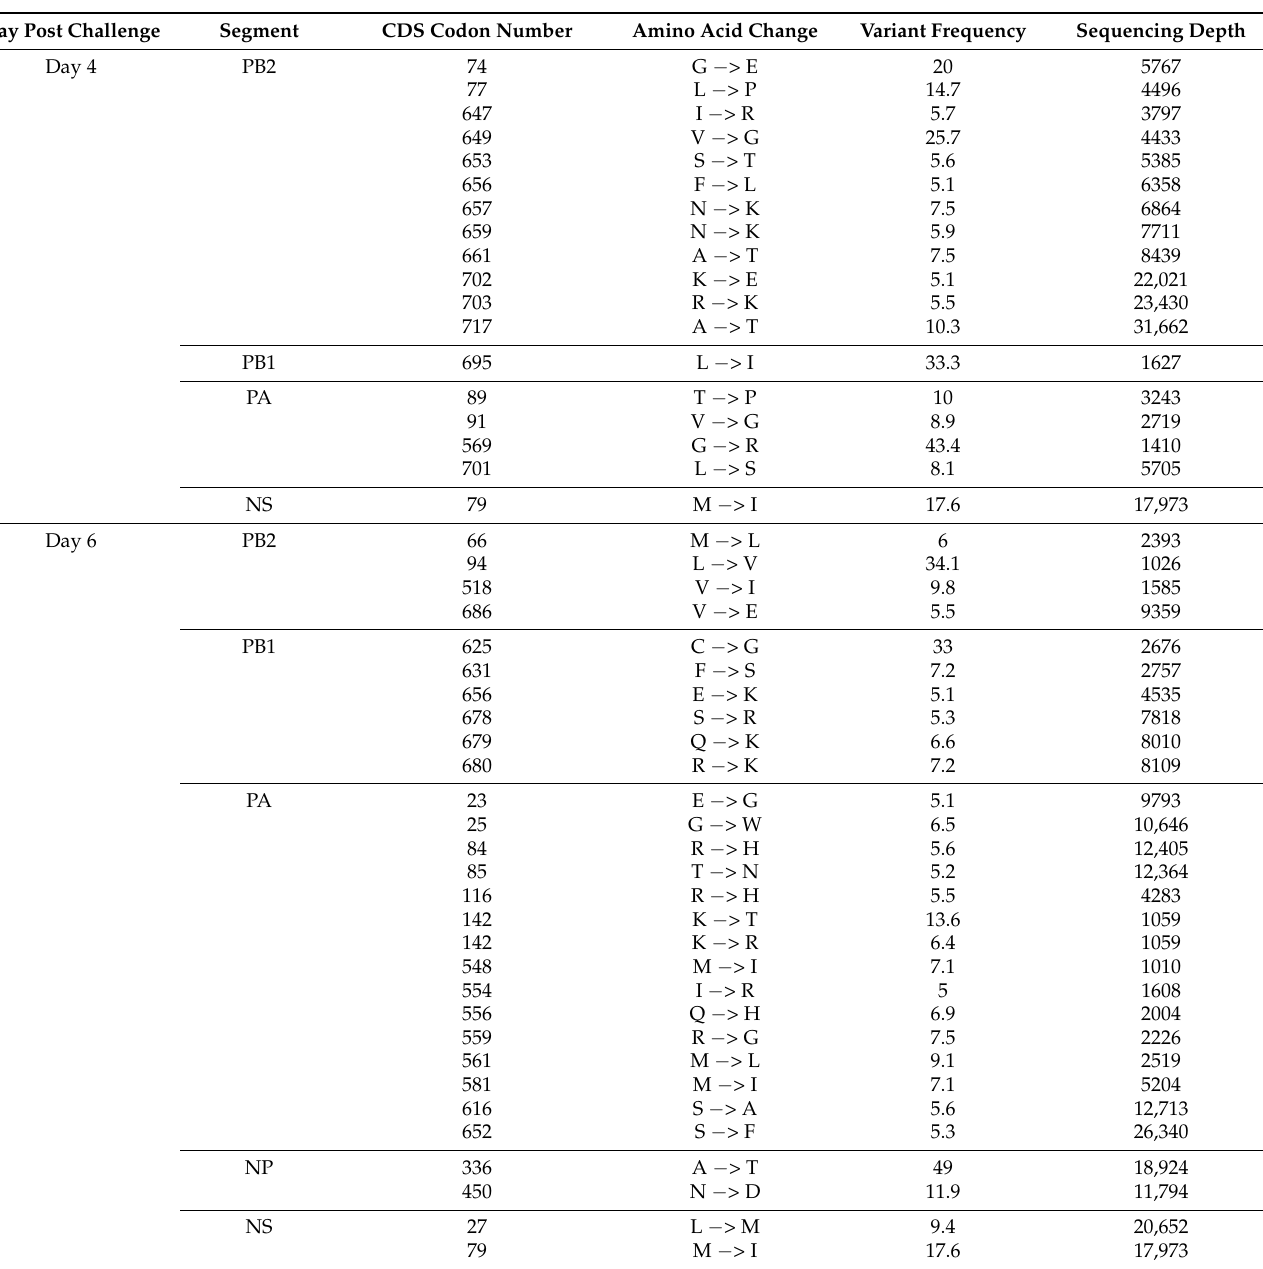
Table 1. The non-synonymous changes in the A/duck/AL/2017 (H7N9) LPAIV viral genome segments recovered from swab samples at day 4 and 6 post challenge from directly infected SPF chickens. Chickens were challenged intranasally with 10 6 EID50 of virus inoculum per bird at three weeks of age. The frequencies of viral variants were computed using a minimum sequence coverage of 1000 reads covering the base and a minimum variant frequency of 5%. The maximum p -value of 10 − 6 and a minimum strand-bias p -value of 10 − 5 when exceeding a 65% bias were used to call the variants with an average quality >